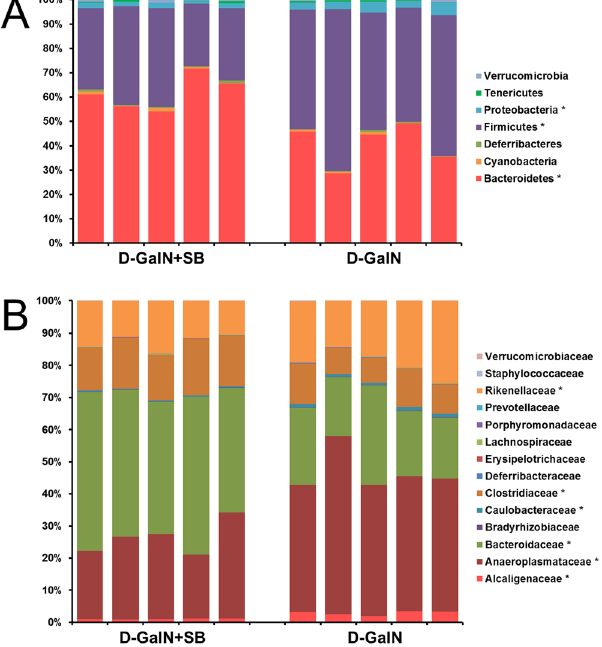
Figure 4. Variation in bacterial community composition in the ileum at phylum ( A ) and family ( B ) levels. Undetected taxa are not displayed in the chart. * P-value < 0.05 according to Student’s